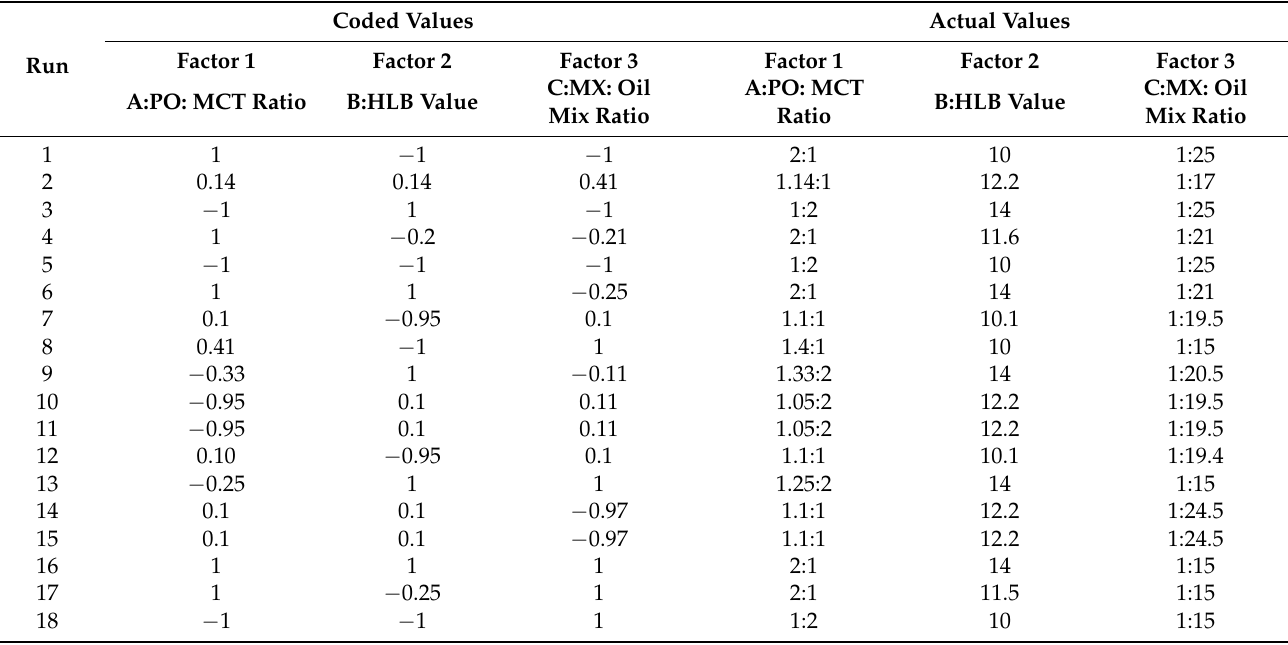
Table 1. The independent factors and responses for the design of